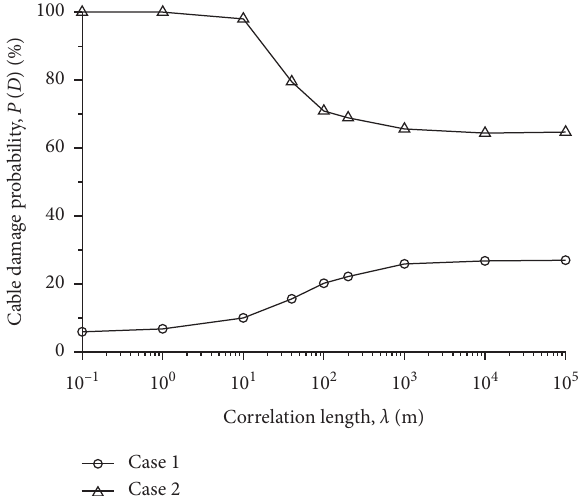
Figure 14: Cumulative distribution function (CDF) of the maxi- mum cable strain ε max